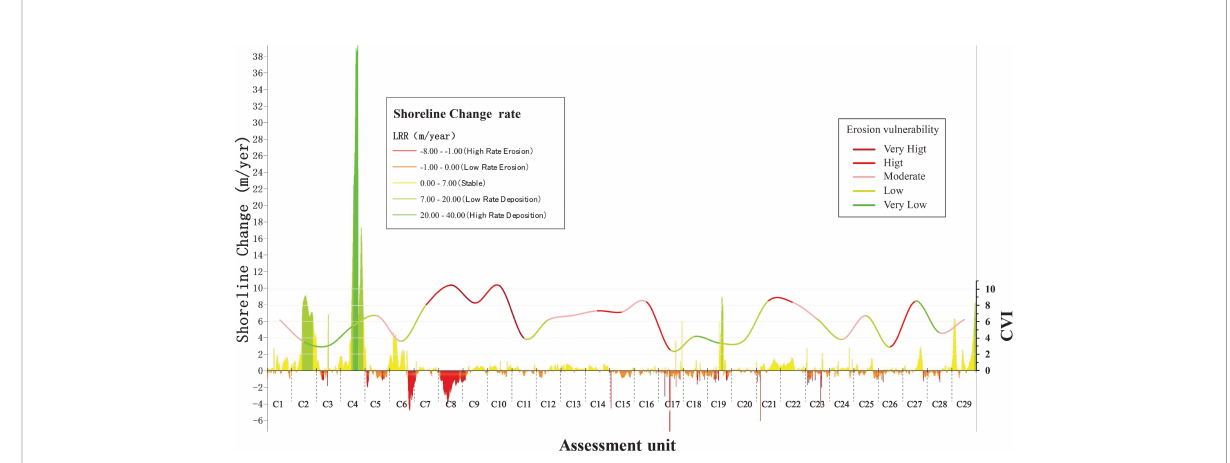
FIGURE 10 Shoreline change rate and vulnerability curve of different typical coasts (The left side is the legend of Change rate of shoreline, and the right side is the vulnerability index curve of the corresponding section).